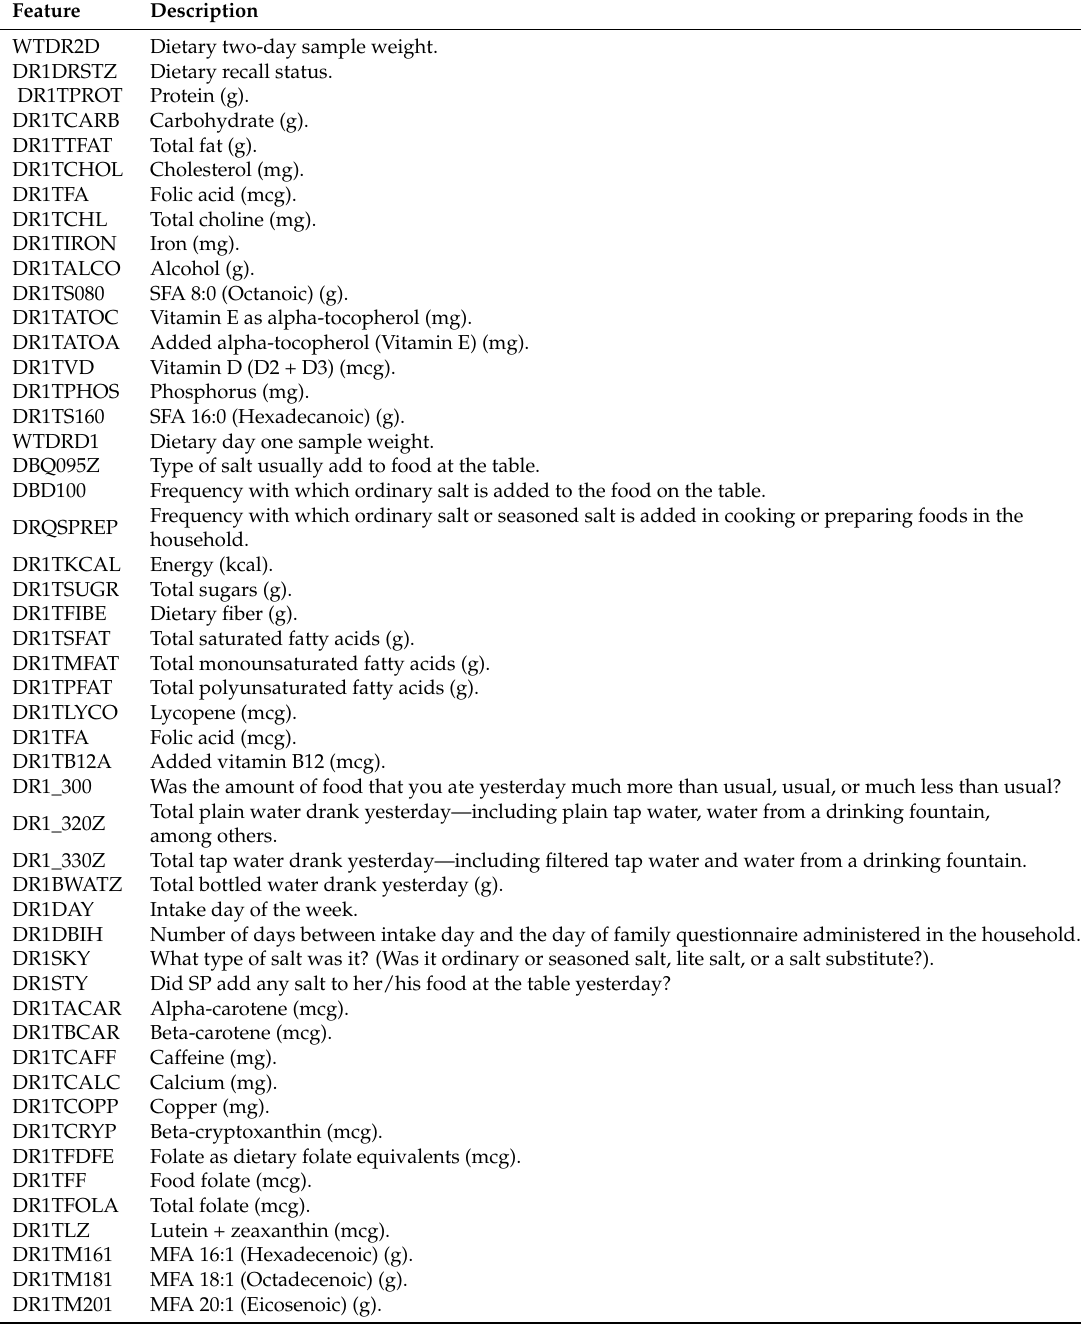
Table A3. Description of dietary